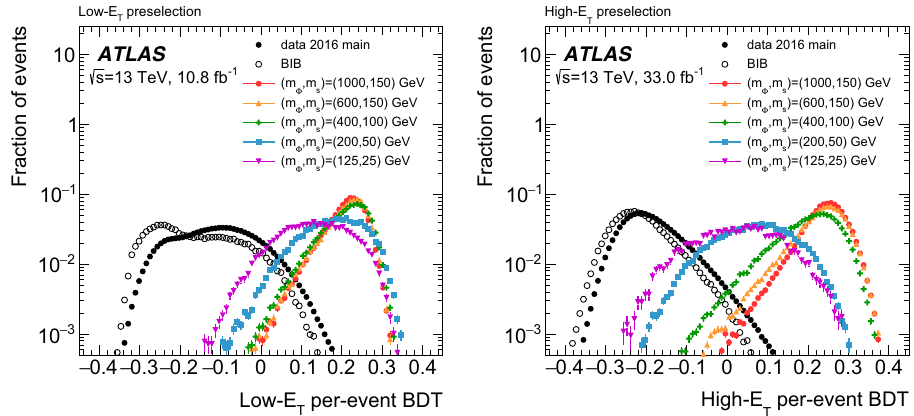
Fig. 5 Distribution of the low- E T per-event BDT (left) and high- E T per-event BDT (right) on main data, BIB data and five signal samples after